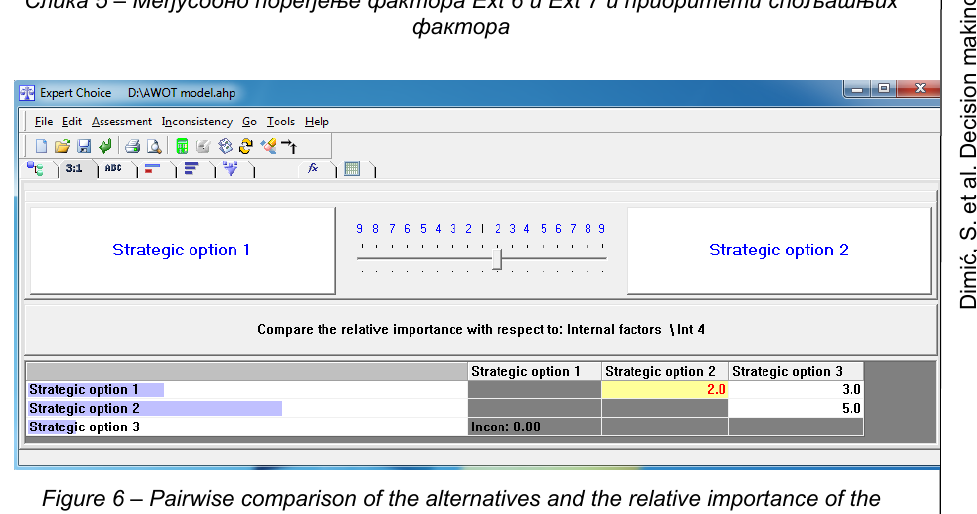
Figure 6 – Pairwise comparison of the alternatives and the relative importance of the alternatives Рис . 6 – Парное сравнение и относительная важность